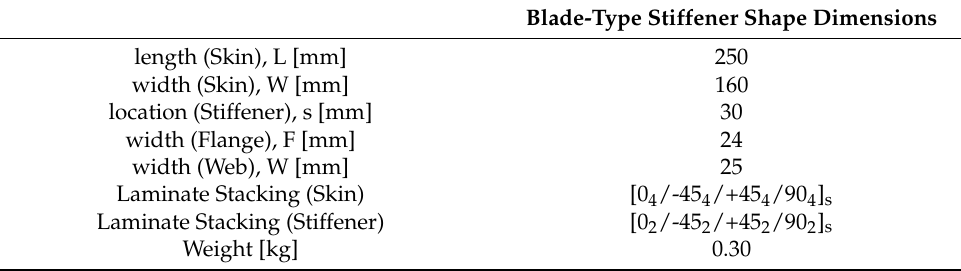
Figure 7. The geometry of the blade stiffened the panel. Table 1. Geometry information and blade-type stiffener shape